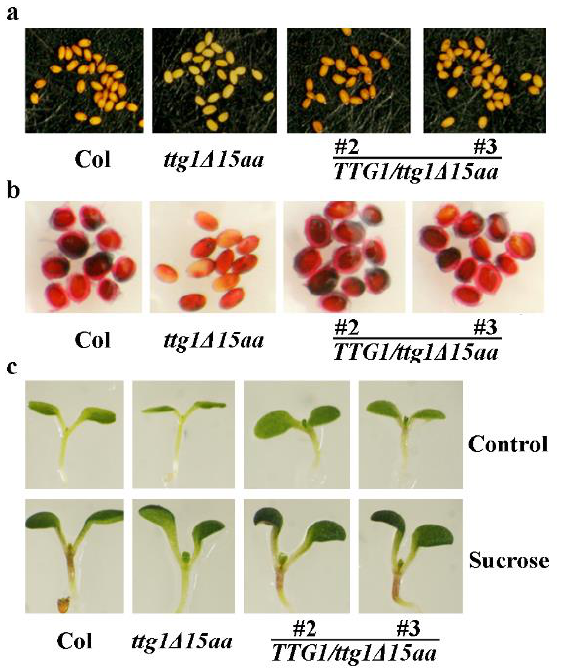
Figure 5. Expression of TTG1 under the control of its native promoter restores secondary metabolism in the ttg1 ∆ 15aa mutant. ( a ) Seed coat color in the Col wild type, the ttg1 ∆ 15aa mutant and the TTG1 / ttg1 ∆ 15aa transgenic plants. Pictures were taken under a Motic K microscope by using an EOS 1100D digital camera. ( b ) Mucilage production in the Col wild type, the ttg1 ∆ 15aa mutant, and the TTG1 / ttg1 ∆ 15aa transgenic plants. Seeds were stained with 0.01% ( w/v ) Ruthenium red for 2 h, and pictures were taken under a Motic K microscope by using an EOS 1100D digital camera. ( c ) Anthocyanin accumulation in seedlings of the Col wild type, the ttg1 ∆ 15aa mutant, and the TTG1/ttg1 ∆ 15aa transgenic plants in response to sucrose. Seeds of Col wild type, the ttg1 ∆ 15aa mutant, and the TTG1 / ttg1 ∆ 15aa transgenic plants were germinated and grown on half MS plates with or without 3% sucrose. Pictures were taken from 6-day-old seedlings. As we have previously shown that the bHLH transcription factor GL3 alone functions as an activator, whereas TTG1 alone is not able to activate reporter gene expression when recruited to the promoter region of the Gal:GUS reporter gene by a fused GD domain [40]. Therefore, we used GL3 as an example to examine if TTG1 ∆ 15aa may be still able to interact with bHLH transcription factors. As shown in Figure 6a, the co-transfection of GD-TTG1 and GL3 activated the Gal4:GUS reporter gene expression, whereas the co-transfection of GD-TTG1 ∆ 15aa and GL3 failed to do so, suggesting that TTG1 ∆ 15aa is unable to interact with GL3. Assays with truncated TTG1 proteins indicate that the deletion of the last three TTG1 with GL3 (Figure 6a, see Section 2.5 for details). Considering that amino acids